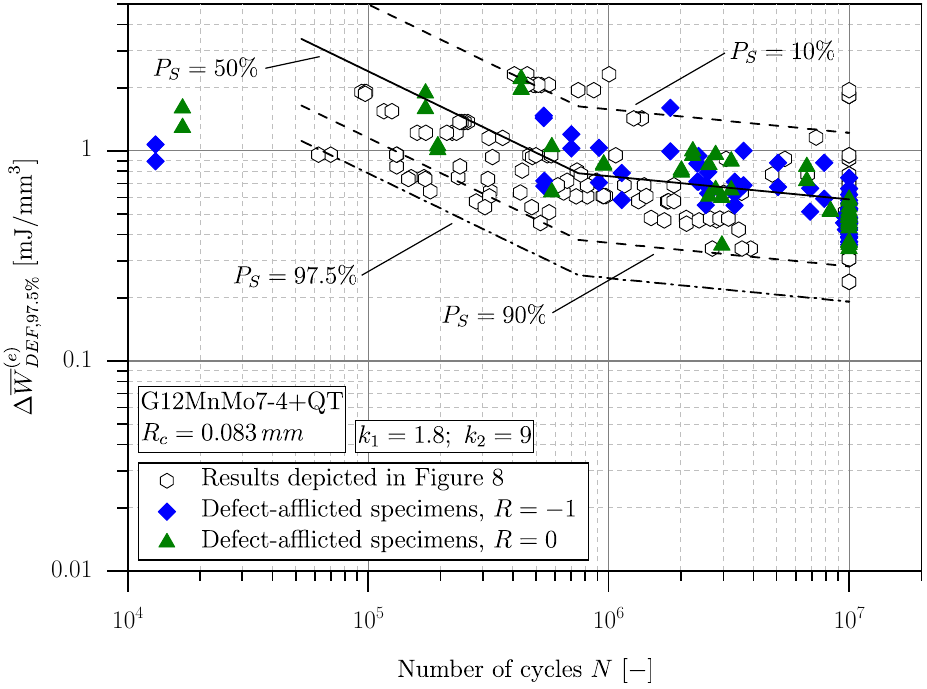
Figure 15. Fatigue assessment results of the defect-afflicted cast steel